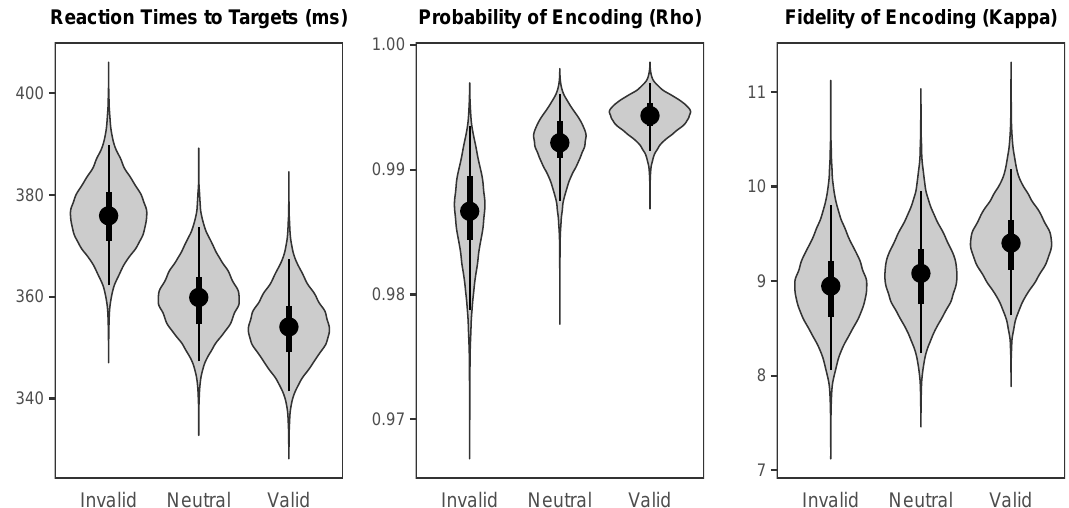
Figure 4. The probability distributions, medians, and HDIs for the population means of the parameters of interest for each cue condition for endogenous cues.